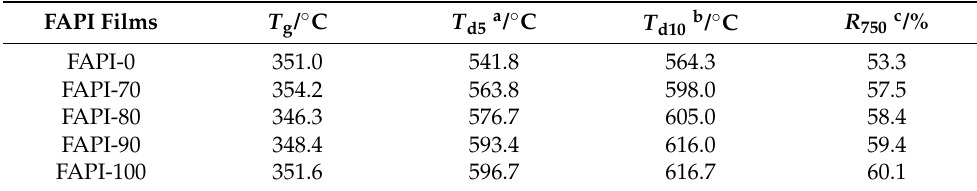
Figure 5. TGA curves of the FAPI films with different biphenyl content in polymer backbone. Table 3. Thermal properties of the FAPI